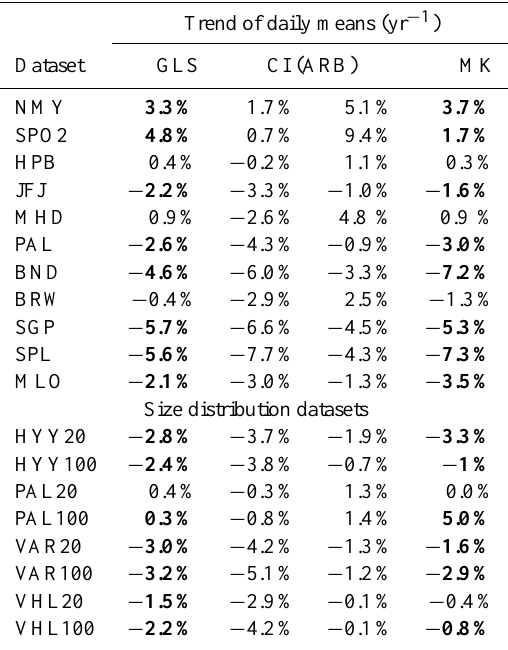
Table 3. N trends for the period 2001–2010 for stations with at least 9yr of data in that period. Notation as in Table 2. Trends are shown only for the all-day means, but as in Table 2, the differences with night-time mean trends are